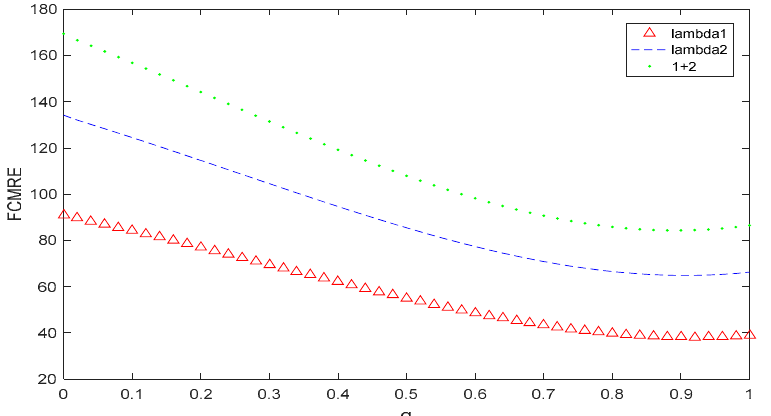
Figure 4. The fractional cumulative residual MRE of exponential distribution with λ 1 = 0.3, λ 2 = 0.4 and the fractional cumulative residual MRE of S 1 + S 2